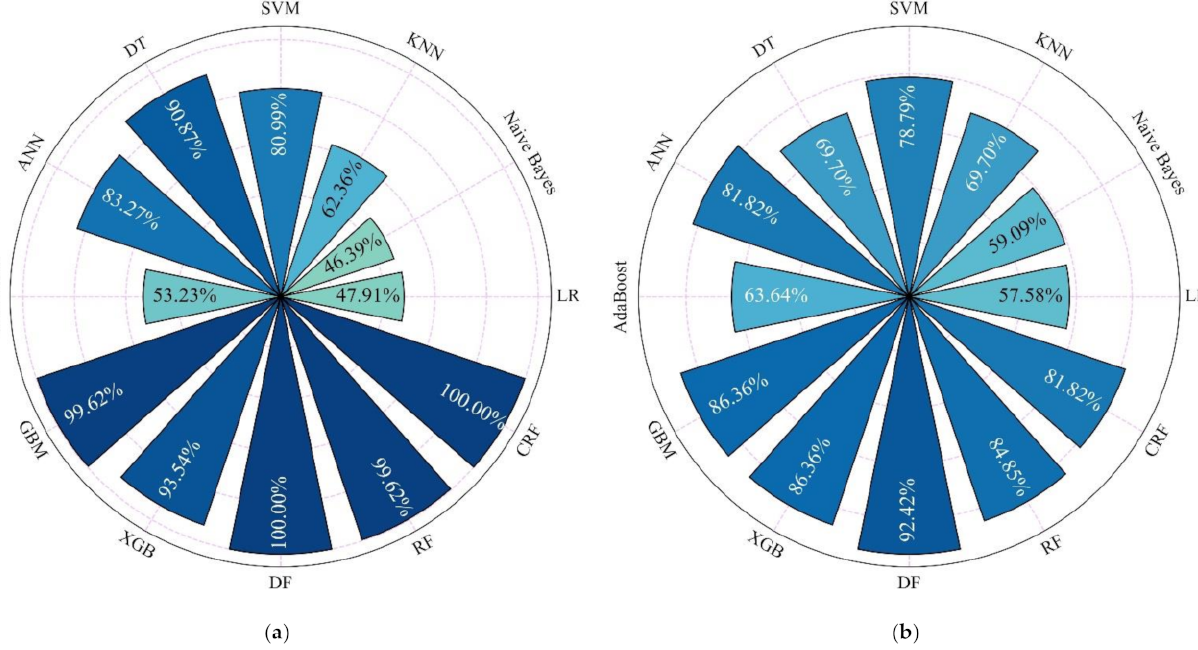
Figure 10. Training and testing results of the developed models. ( a ) Training accuracy; ( b ) Testing